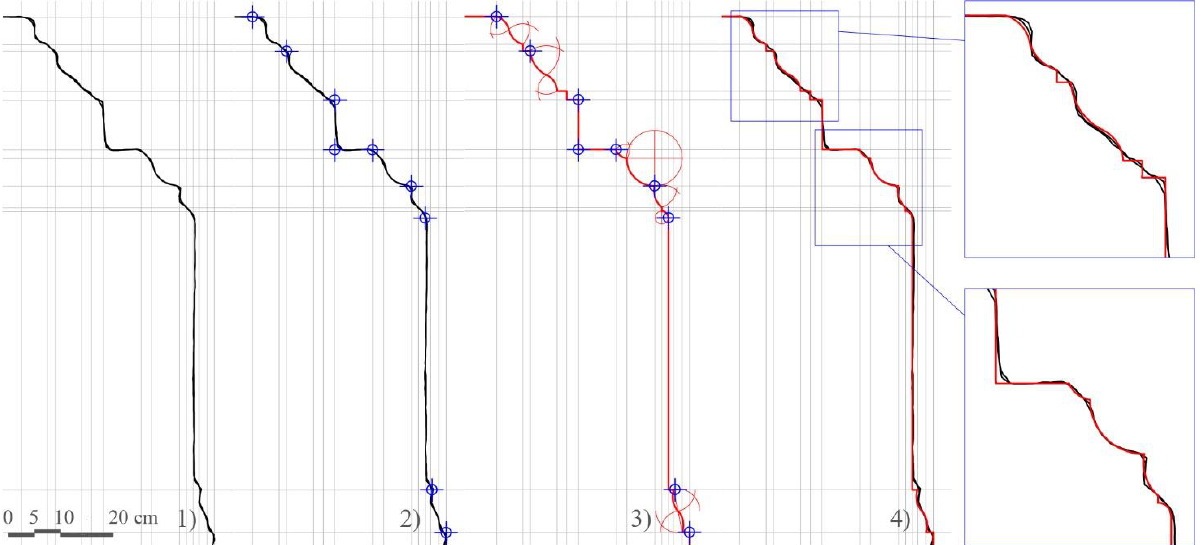
Figure 4. The steps for the construction of the profiles: 1) section obtained from the point cloud with the JRC Reconstructor software; 2) identification of significant points; 3) interpretation and geometric construction of mouldings; 4) comparison between the section and the determined